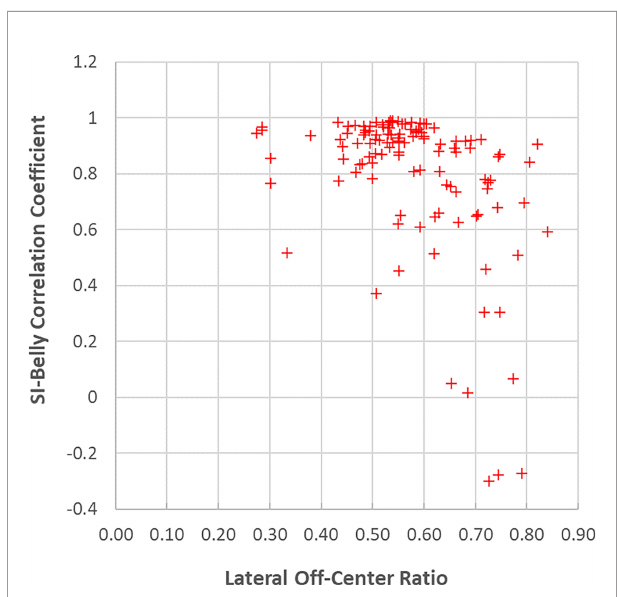
FIGURE 8 | SI-Belly correlation coef fi cients as a function of the lateral off- center